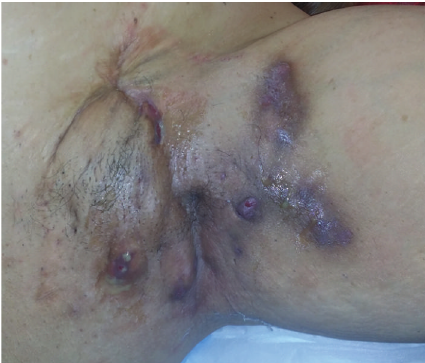
Figure 1: Image of the left axilla on presentation showing multiple abscess formation with pus discharge and surrounding induration, inflammation, and scarring.